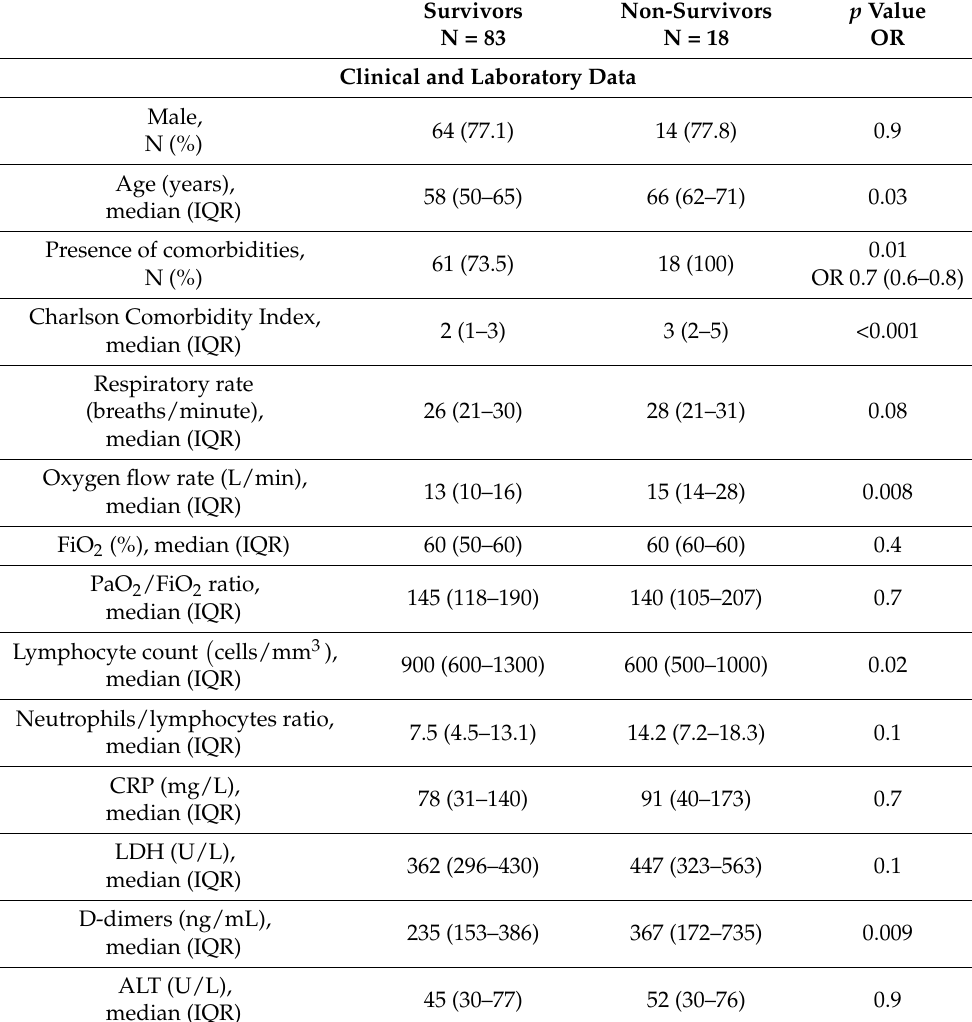
Table 1. Patient characteristics and laboratory findings, according to the outcome, recorded at TOC